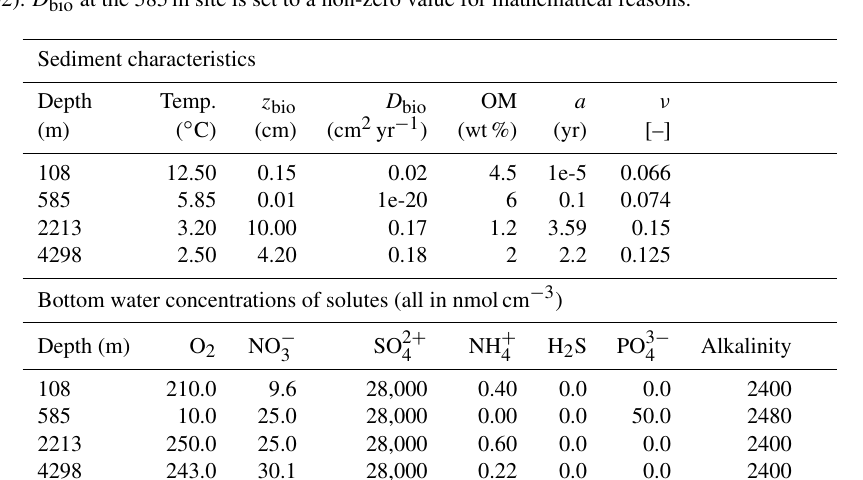
Table 1. Model boundary conditions and parameters for the simulated sediment profiles in Fig. 3 were taken from Hülse et al. (2018), who adapted boundary conditions and parameters from the original publications, except OM reactivity parameters a and ν . For a detailed description of the study sites in the Santa Barbara Basin (108 and 2213m) and the Iberian margin (585 and 4298m), see Reimers et al. (1996) and Epping et al. (2002). D bio at the 585m site is set to a non-zero value for mathematical